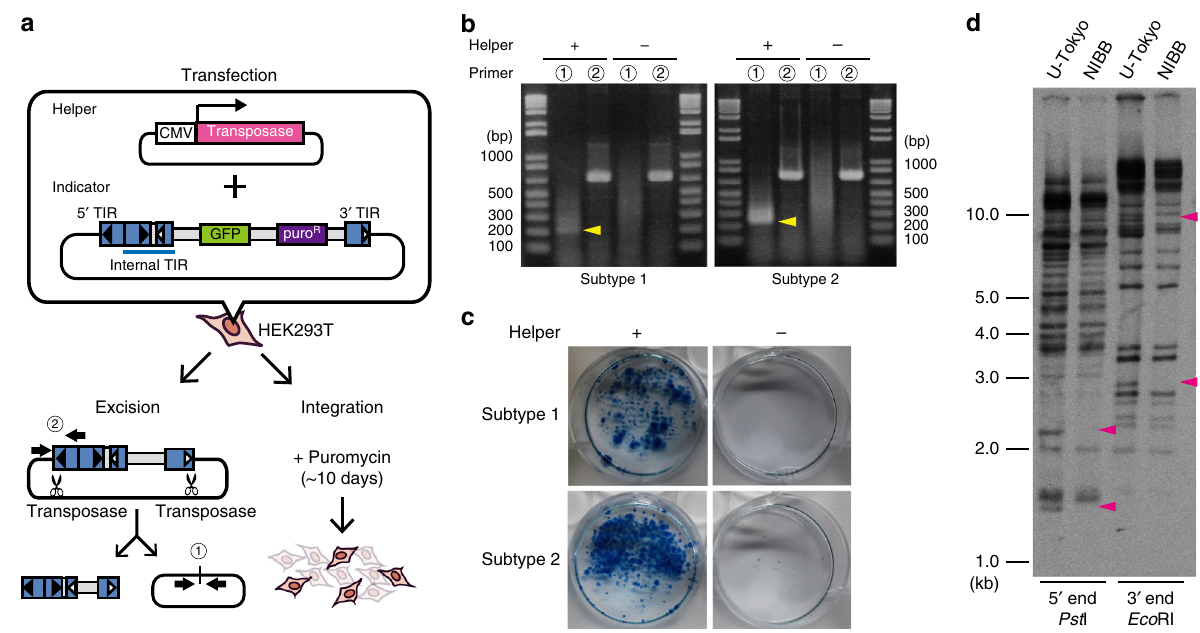
Fig. 3 Teratorn retains transposition activity. a A schematic of the transposition assay. In the helper plasmid, Teratorn transposase gene was